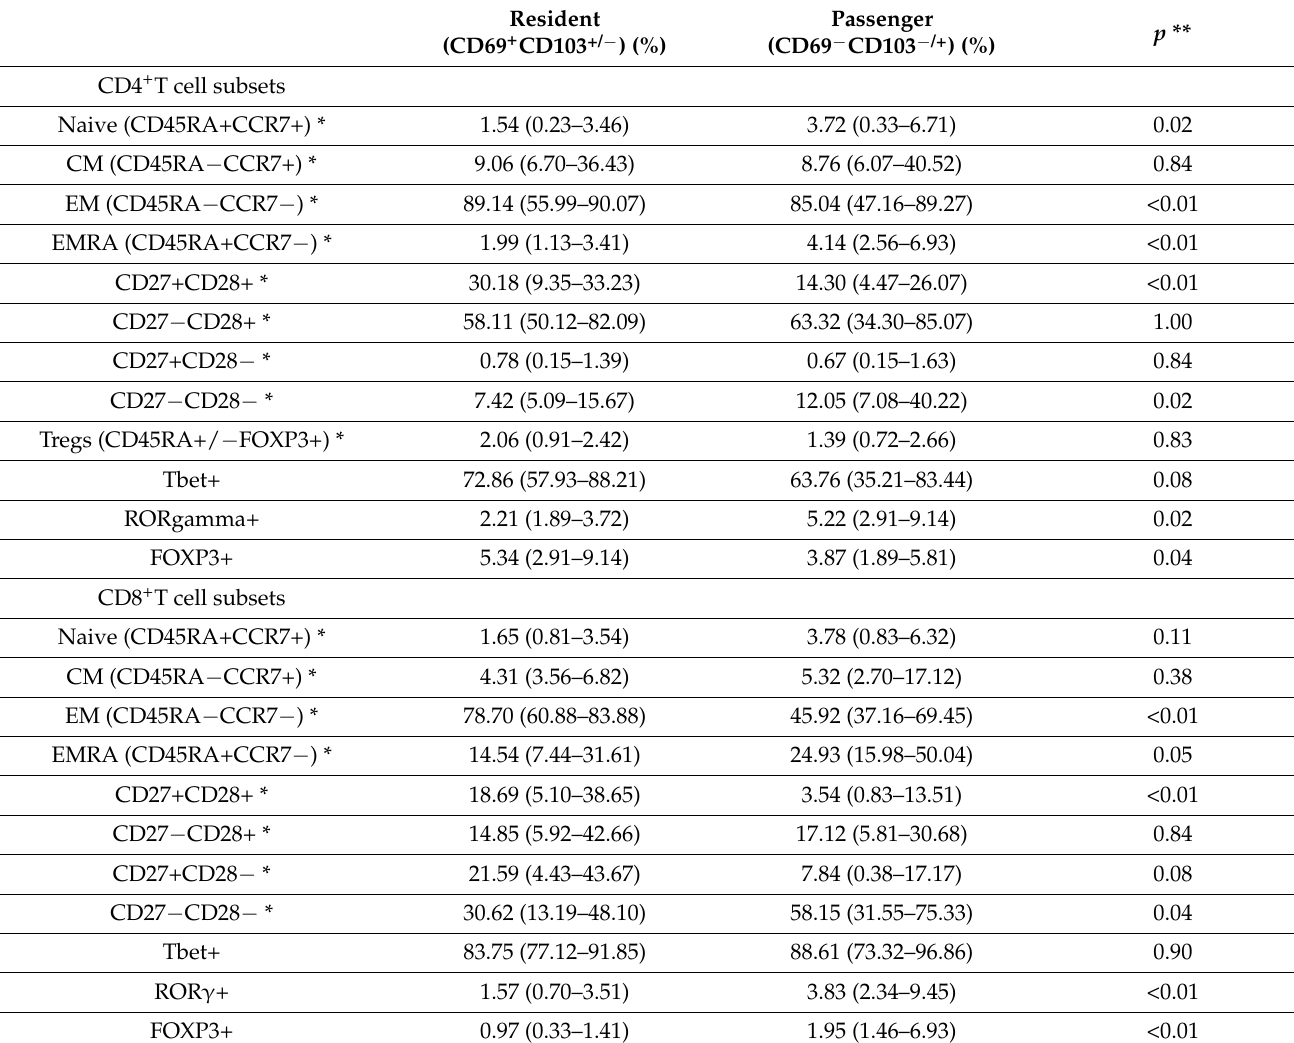
Table 3. CD4+ and CD8+ T cell phenotype characteristics following direct enzymatic dissociation of kidney